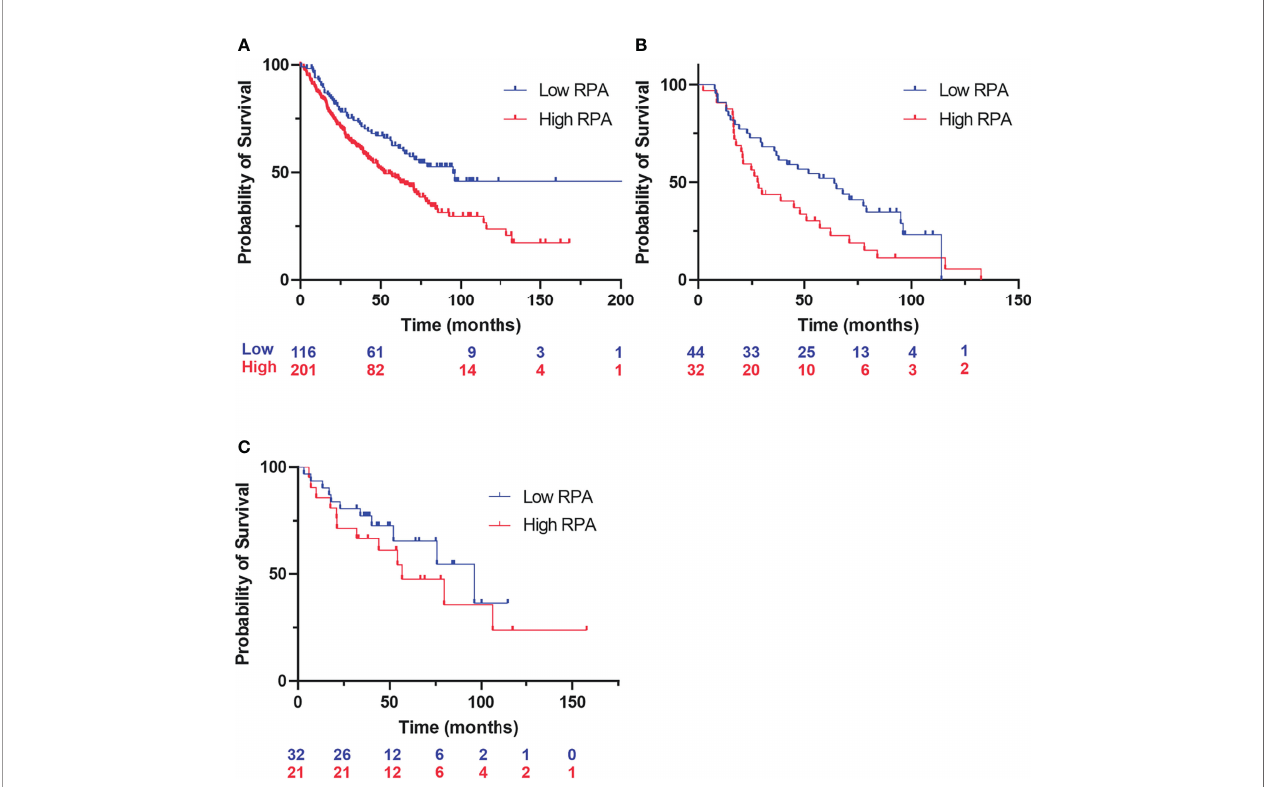
FIGURE 1 | Kaplan – Meyer retrospective analysis of overall survival as a function of replication protein A (RPA) gene expression in non-small cell lung cancer (NSCLC). Blue numbering indicates patients with low RPA expression, red numbering indicates patients with high RPA expression. Analysis represents a 500-patient cohort from the caARRAY, with optimized cutoff. (A) Former and current smokers. HR = 1.63 (1.17 – 2.28) log-rank: p = 0.0035. (B) Former and current smokers who received chemotherapy. HR = 1.69 (1 – 2.86) log-rank: p = 0.049. (C) Never